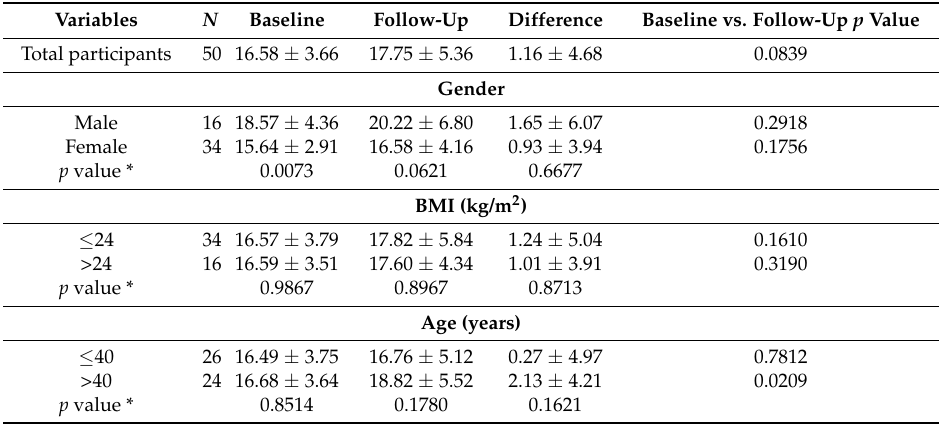
Table 4. Comparison of changes in serum 25(OH)D before and after the intervention among the white-collar worker study population